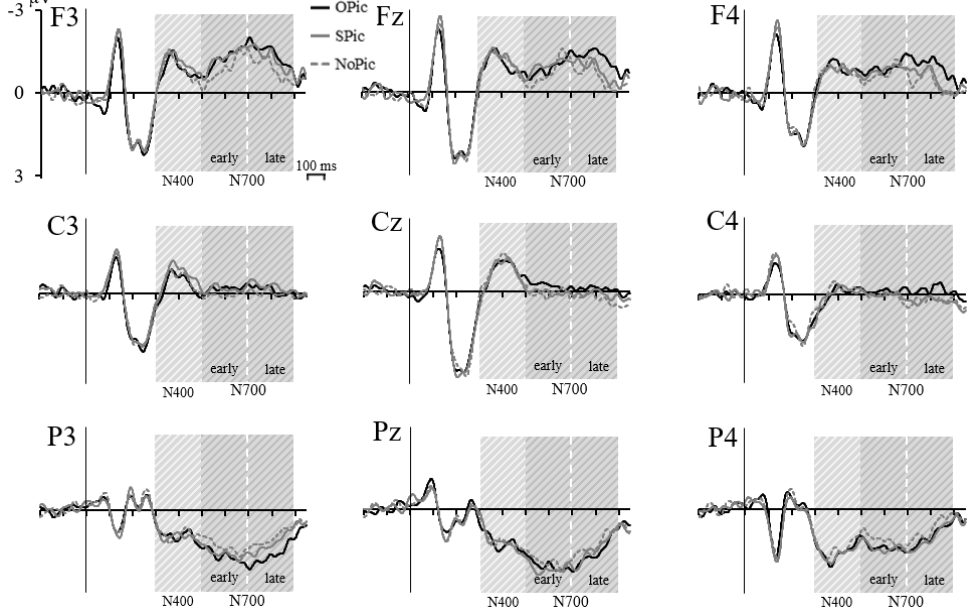
Figure 3. Novel word ERPs. Grand averages ( n = 21) of the ERP waveforms elicited by novel words associated with object (OPic), structure (SPic) or no pictures (NoPic) for all analyzed electrodes. The shaded areas mark the time windows of the N400 (300–500 ms) and the early N700 (500–700 ms) and late N700 (700–900 ms).